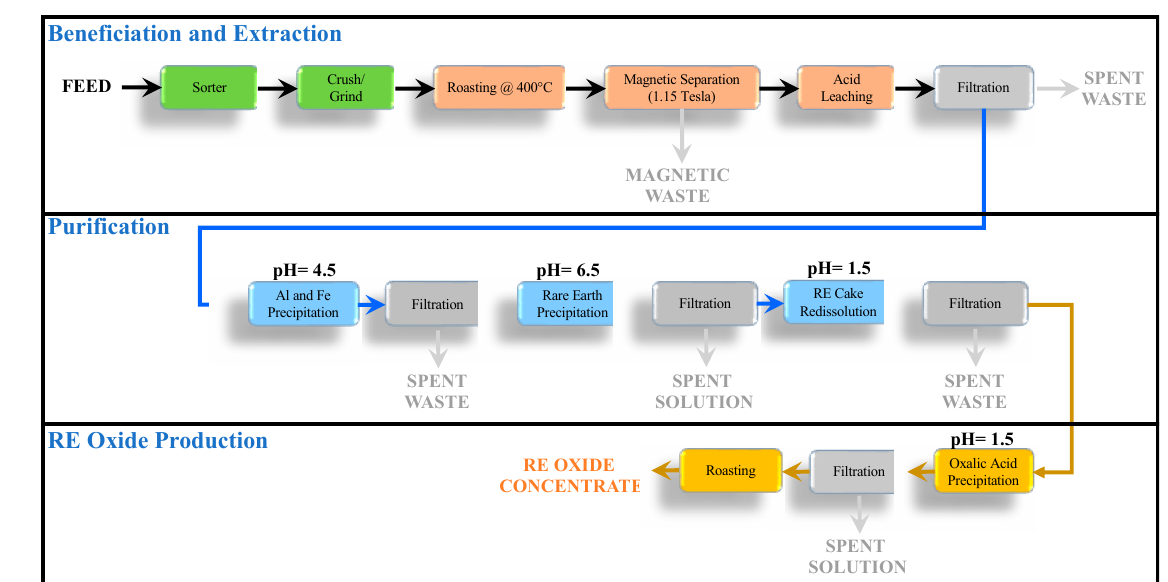
Figure 13. Flowsheet for single-stage calcination followed by magnetic separation in the hydrometallurgical extraction and purification of REEs from coal-based feedstocks.